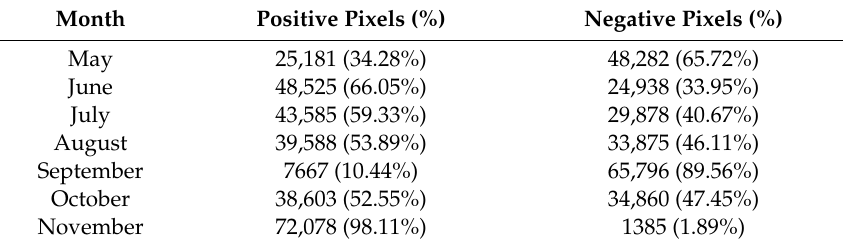
Table 3. The number of pixels and their proportions of the correlation coe ffi cients between monthly temperature and